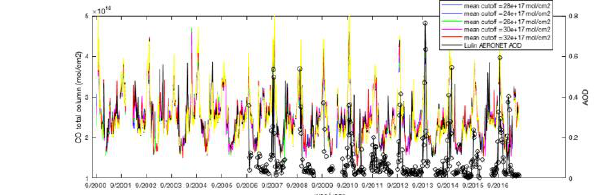
Figure 7. Measured AERONET AOD [circles] from Lulin Mountain, and CO total column mean values over various biomass burning regions with cutoffs as given in the plot. Computing the correlation coefficient between the average CO column loading over each urban region, and the AERONET AOD values at both Dongsha Island and Lulin Mountain yield results which are identical for each of the cases. This is because each case is capable of reproducing the far-downwind transport which impacts the high AOD conditions at these sites. This is when we match the maximum to each other.